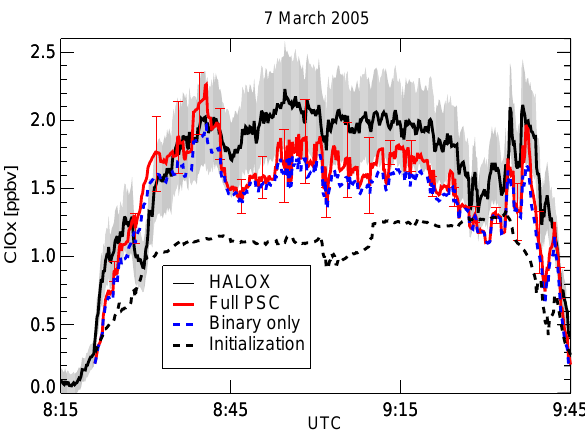
Fig. 4. Comparison of HALOX in-situ data and CLaMS simula- tions for the flight on 7 March 2005. The solid black line marks the HALOX measurements (ClO+2 · Cl 2 O 2 ) with its accuracy shaded grey and blue the simulations with the error bars showing their un-